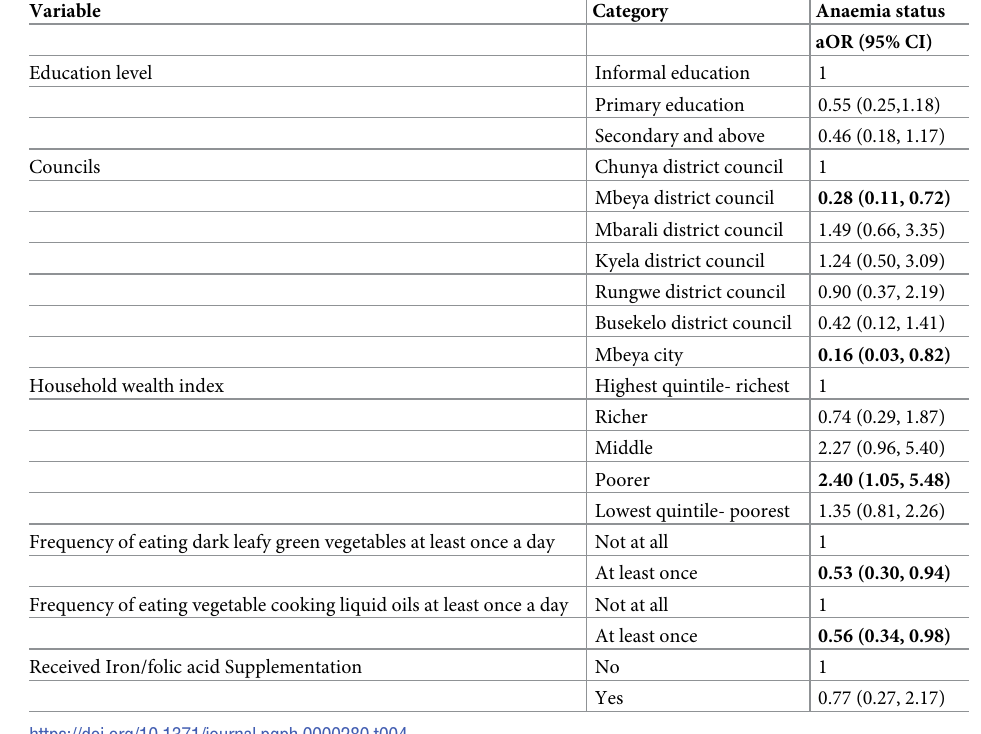
Table 4. Multivariate logistic regression of anaemia status with socio-demographic, reproductive health, and nutrition characteristics among pregnant women attending Antenatal Clinic in Mbeya, Tanzania (n =